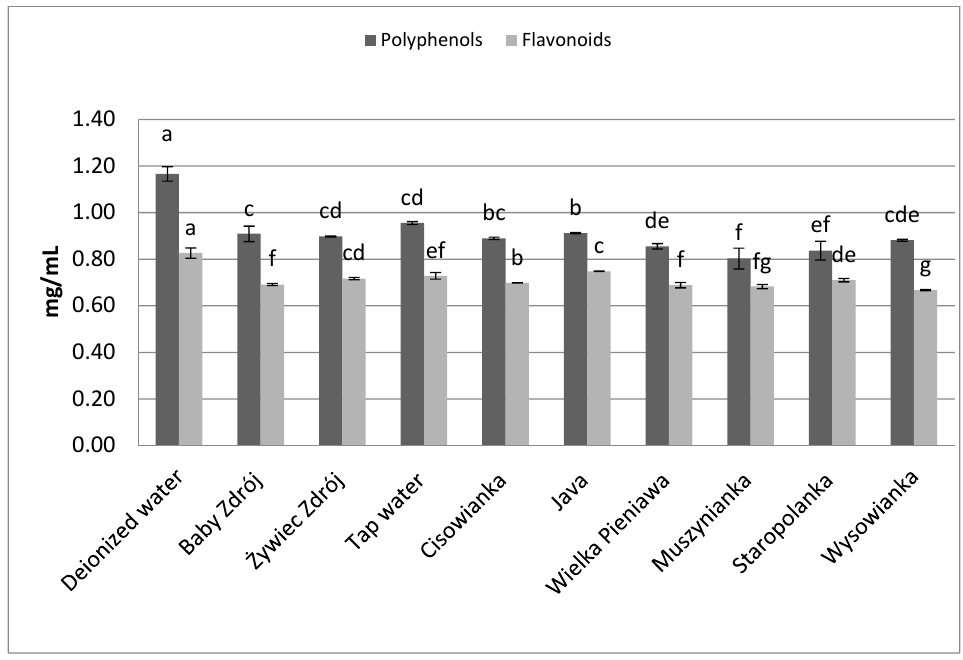
Figure 9. The effect of water mineralization on the extraction of active substances from inflorescences of lavender. Data are shown as mean ± SD. Different letters (a, b, c, etc.) show a significant difference with p < 0.05. The differences relate to each group of compounds separately.